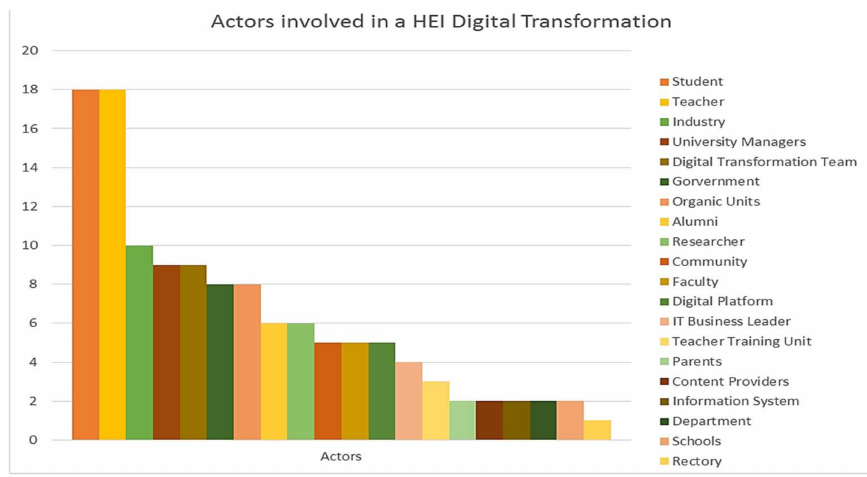
Figure 9. Actors involved in a DT at a